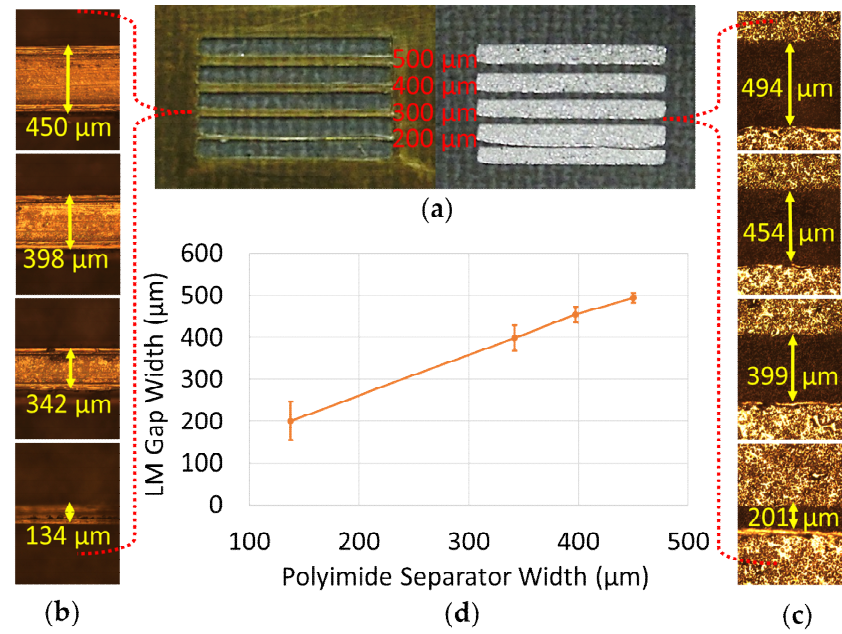
Figure 10. Measurement of gap width between sprayed LM. ( a ) Images of the polyimide mask and the sprayed LM. ( b ) Images of the polyimide mask, with the separator running through the center of the photos. ( c ) Images of the gaps between sprayed LM. ( d ) Measured gap width between sprayed LM lines vs. the polyimide separator width.